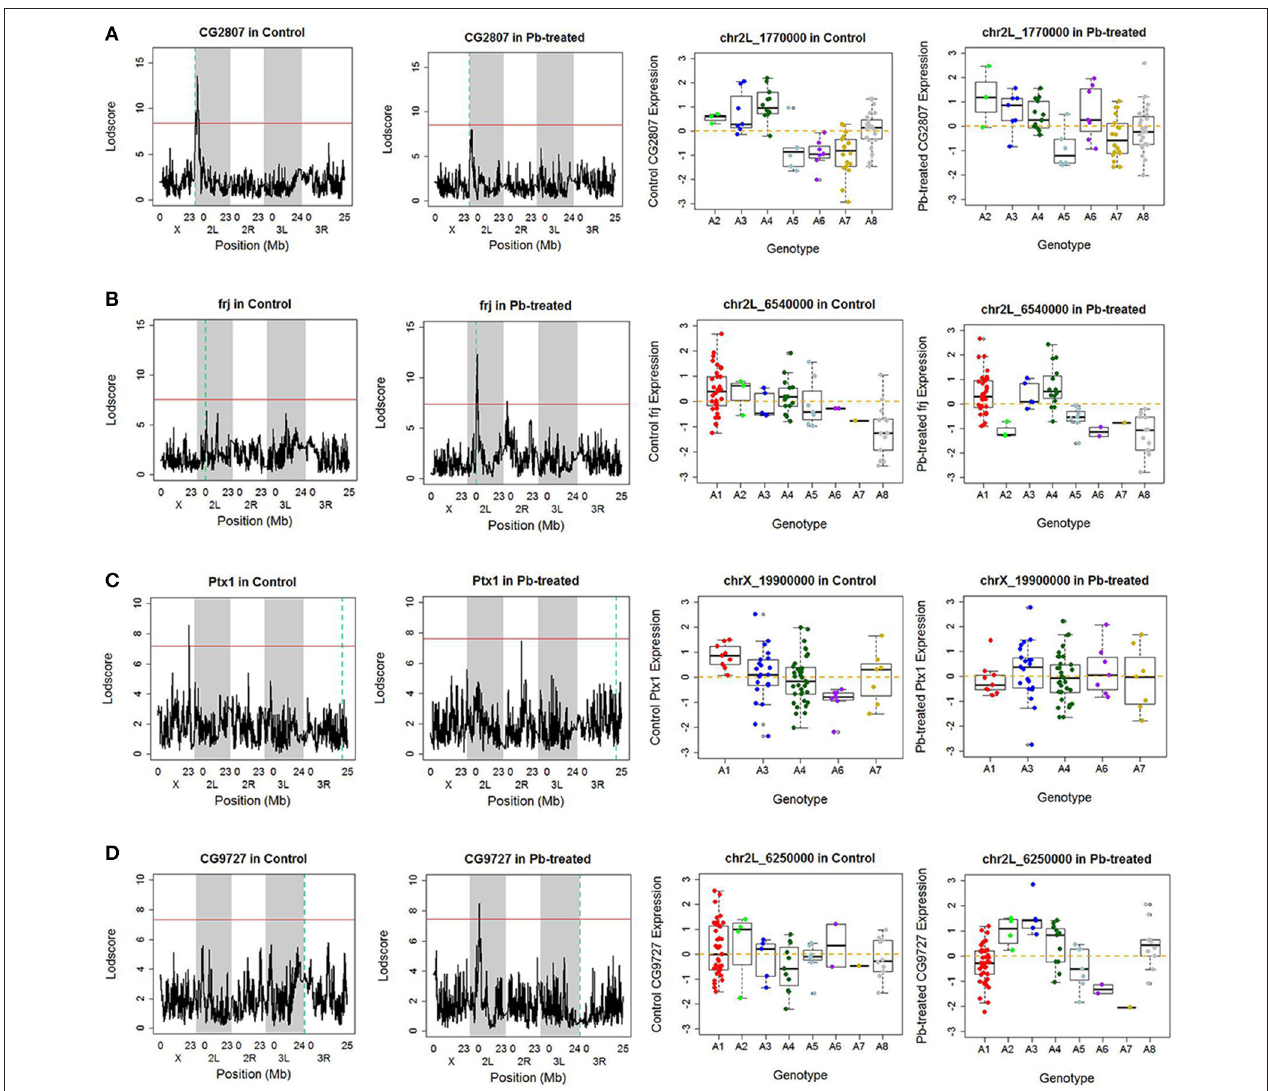
FIGURE 2 | Examples of cis- and trans- eQTLs. (A) One example of control-specific cis- eQTL. In the left two panels, the x-axis represents the Drosophila genomic locations and y-axis represents the LOD score of the gene. The red horizontal line indicates the threshold for p -value to be 0.05 after 1,000 permutation test. The green dash vertical line indicates the location of the gene. If it overlaps with the peak, which suggests strong correlation between the gene and the corresponding location, it is referred as a cis- eQTL, meaning the regulator is near the downstream gene. Since this phenomenon only occurred in control data but not in lead-treated one, this genomic location Chr 2L: 1,770,000 is a control-specific cis- eQTL for gene CG2807. In the right two panels, association of the Chr 2L: 1,770,000 location, which has the highest LOD score in control samples, with quantile normalized CG2807 expression levels following control (not significant) and Lead-treated ( p -value < 0.001). Samples originally from A2, A3, and A4 parental lines exhibited higher expression levels, while samples from A5, A6 and A7 parental lines showed lower expression levels in control. After lead was introduced, the phenomenon disappeared. (B) One example of Lead-specific cis- eQTL. (C) One example of control-specific trans- eQTL. (D) One example of Lead- specific trans-